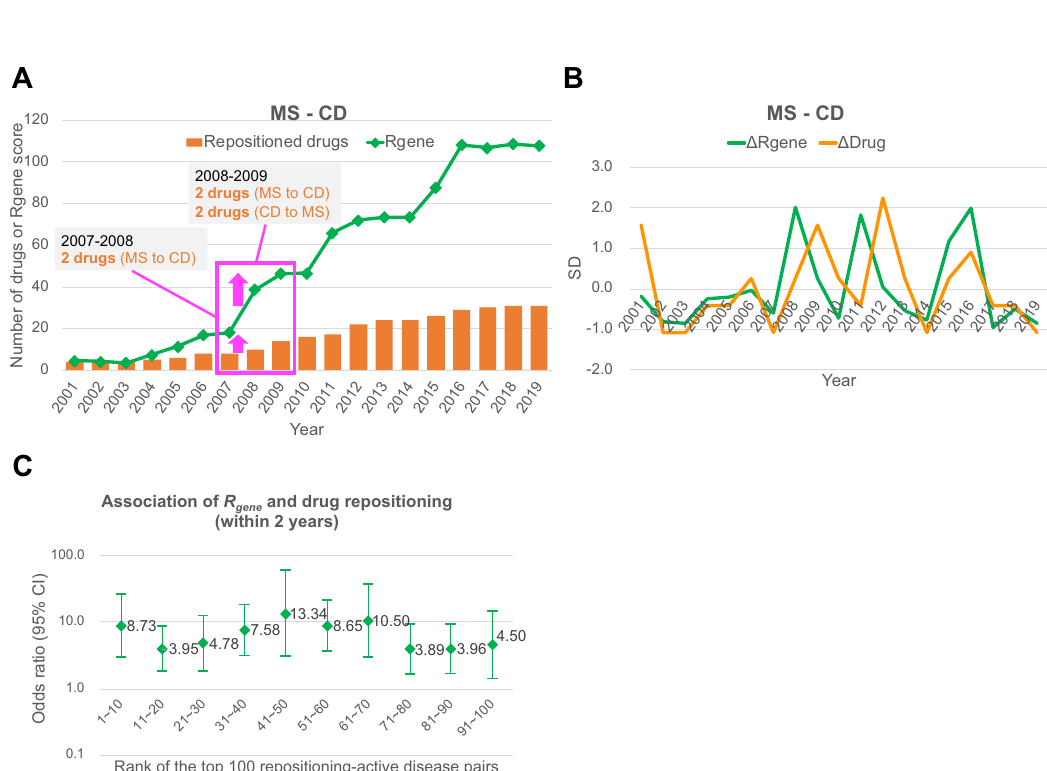
Table 1. Top 10 R gene disease pairs (A. Neuromuscular diseases, D. Immune diseases, M. Digestive diseases).